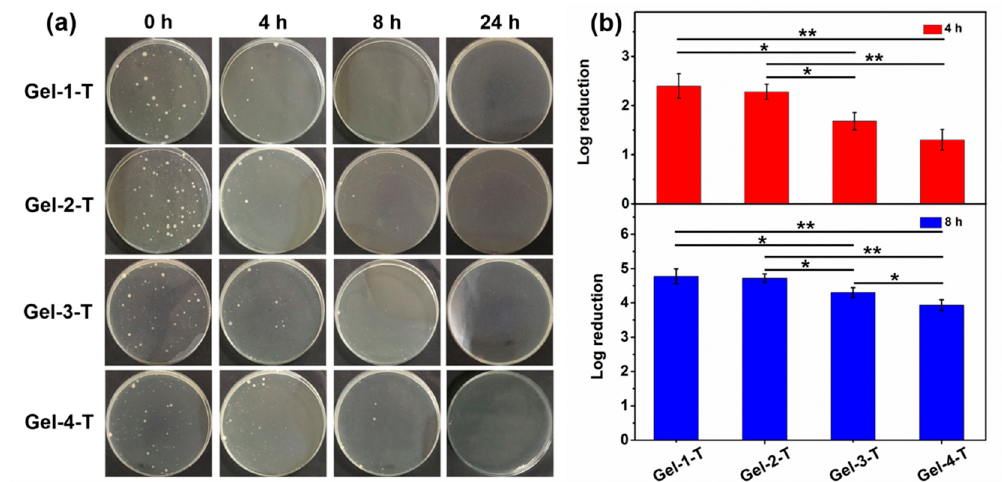
Figure 10. ( a ) Bacterial colonies formed using an agar diffusion assay treated with Gel-1-T, Gel-2-T, Gel-3-T and Gel-4-T against S. aureus at 0, 4, 8 and 24 h. ( b ) The bacterial growth inhibition of Gel-1-T, Gel-2-T, Gel-3-T and Gel-4-T at 4 (red bar) and 8 h (blue bar) investigated by the colony-counting method. * indicates significant difference ( p < 0.05); ** indicates significant difference compared with all other conditions ( p < 0.01). Statistical significance was calculated using the Student’s t -test.